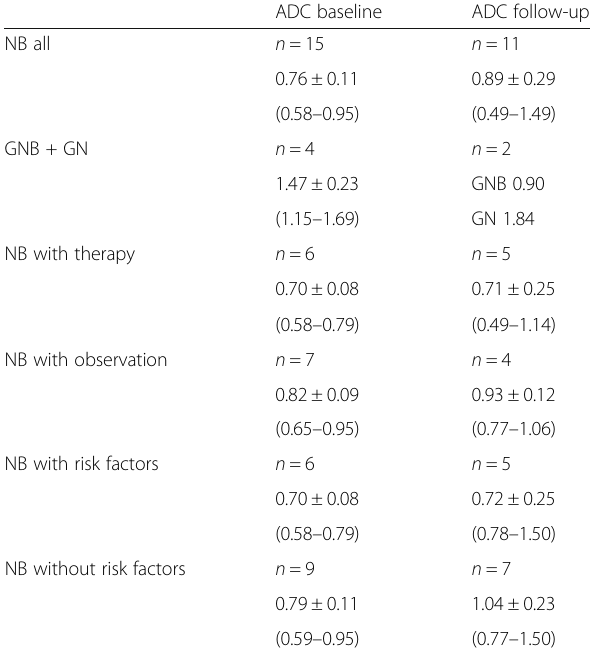
Table 1 ADC values of tumour entities and subgroups at baseline and during follow-up ADC baseline